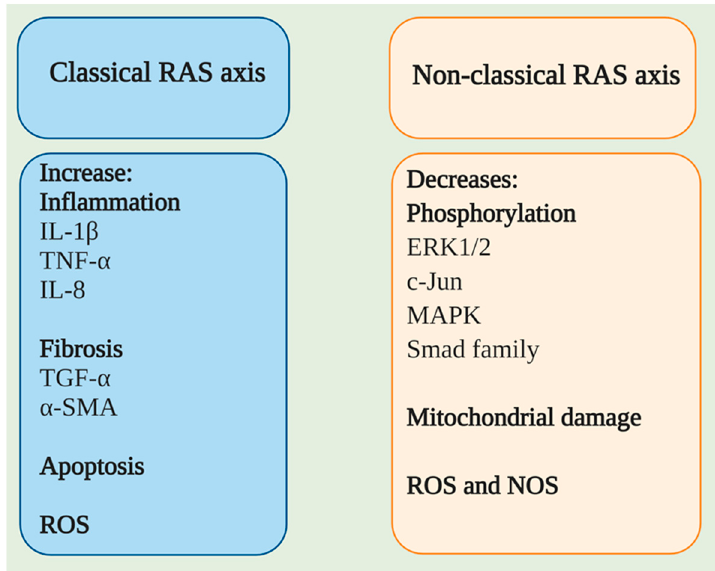
Figure 5. Classical and nonclassical renin-angiotensin (RAS) axes. Biological effects of the classical (ACE/Ang II/AT1R) and nonclassical (ACE2/Ang (1–7)/MasR) axes. IL-1 β : interleukin 1 beta; TNF- α : Tumor necrosis factor alpha; Bcl2: B-cell lymphoma 2; IL-8: interleukin 8, TGF- β : Transforming growth factor beta; α -SMA: alpha smooth muscle actin; ROS: Reactive oxygen species; ERK1/2: extracellular signal-regulated protein kinase 1/2; NOS: Nitric oxide synthase.